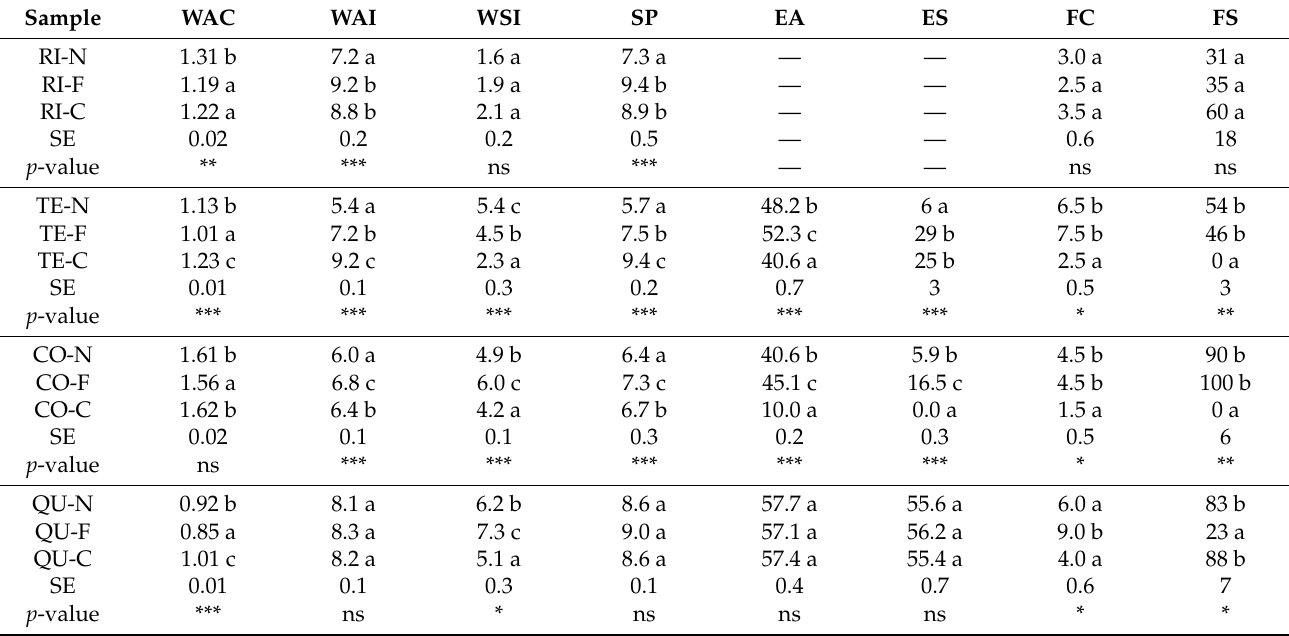
Table 4. Techno-functional properties of the studied